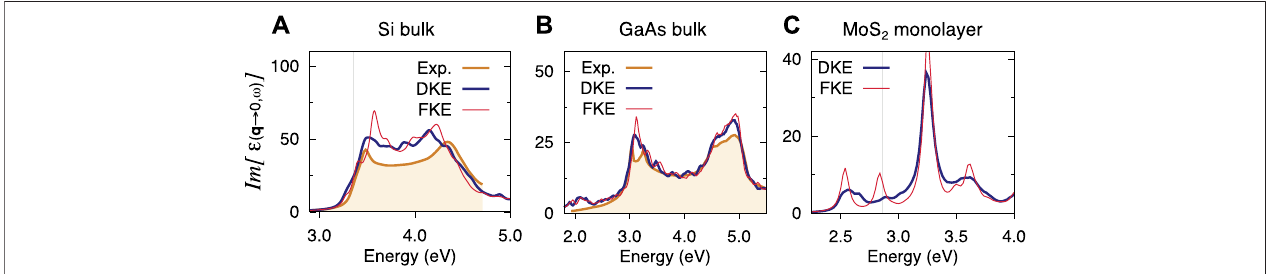
FIGURE 5| Optical absorption spectra of bulk Si (A) , GaAs (B) and MoS 2 monolayer (C) . Comparison of spectra obtained by diagonal kernelextension (DKE) and fullkernel extension (FKE). ForSiand GaAsthecoarse k -gridwas8 × 8 × 8and 10 × 10 × 10respectively andthe fi ne k -grid,60 × 60 × 60.FortheMoS 2 monolayer,the